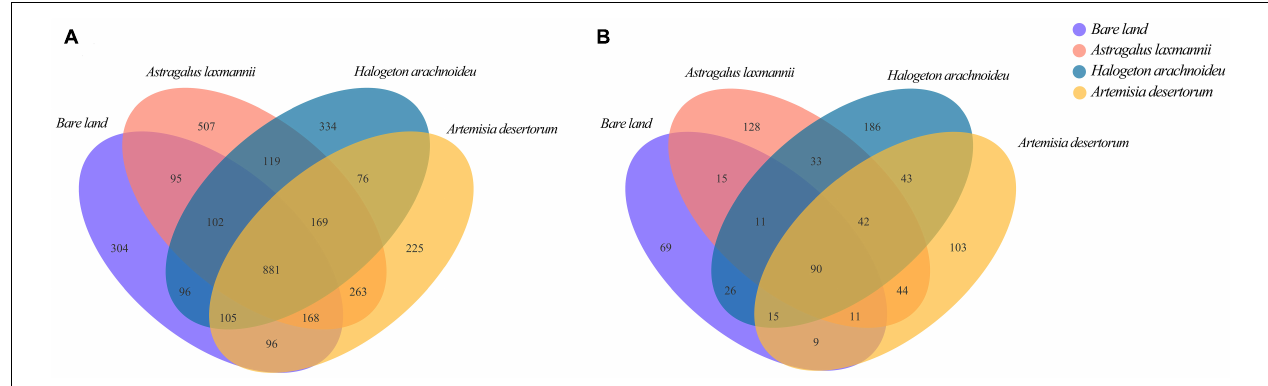
FIGURE 2 | Venn diagram of (A) bacterial and (B) fungal communities in soils from bare land and re-vegetated areas.